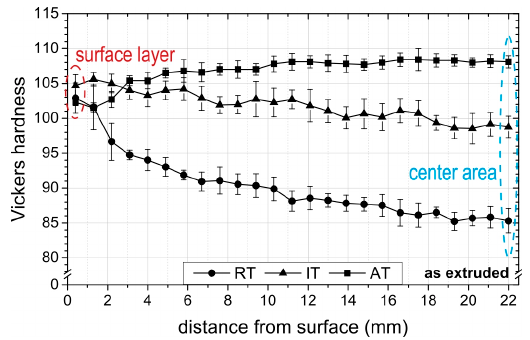
Figure 4. Vickers hardness as a function of distance from surface for the as-extruded materials after RT- (circles), IT- (120 °C, triangles) and AT-extrusion (170 °C, squares). Dashed red and blue ellipses highlight hardness values that represent the surface layers and the center areas, respectively.